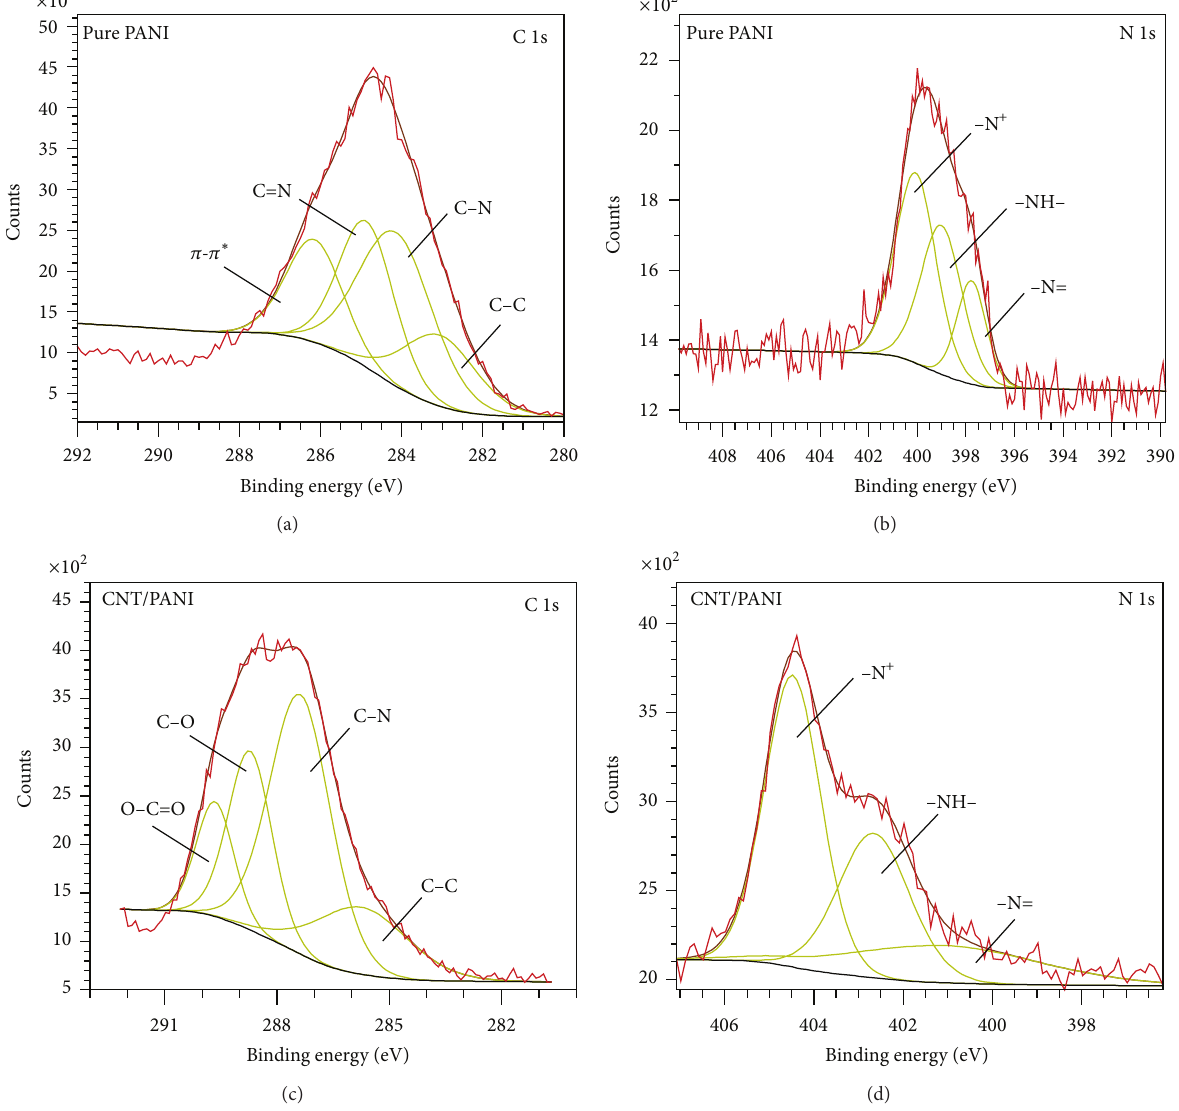
Figure 5: XPS survey spectra of pure PANI and the CNT/PANI composites prepared in HCl medium at core-levels of C 1s and N 1s.